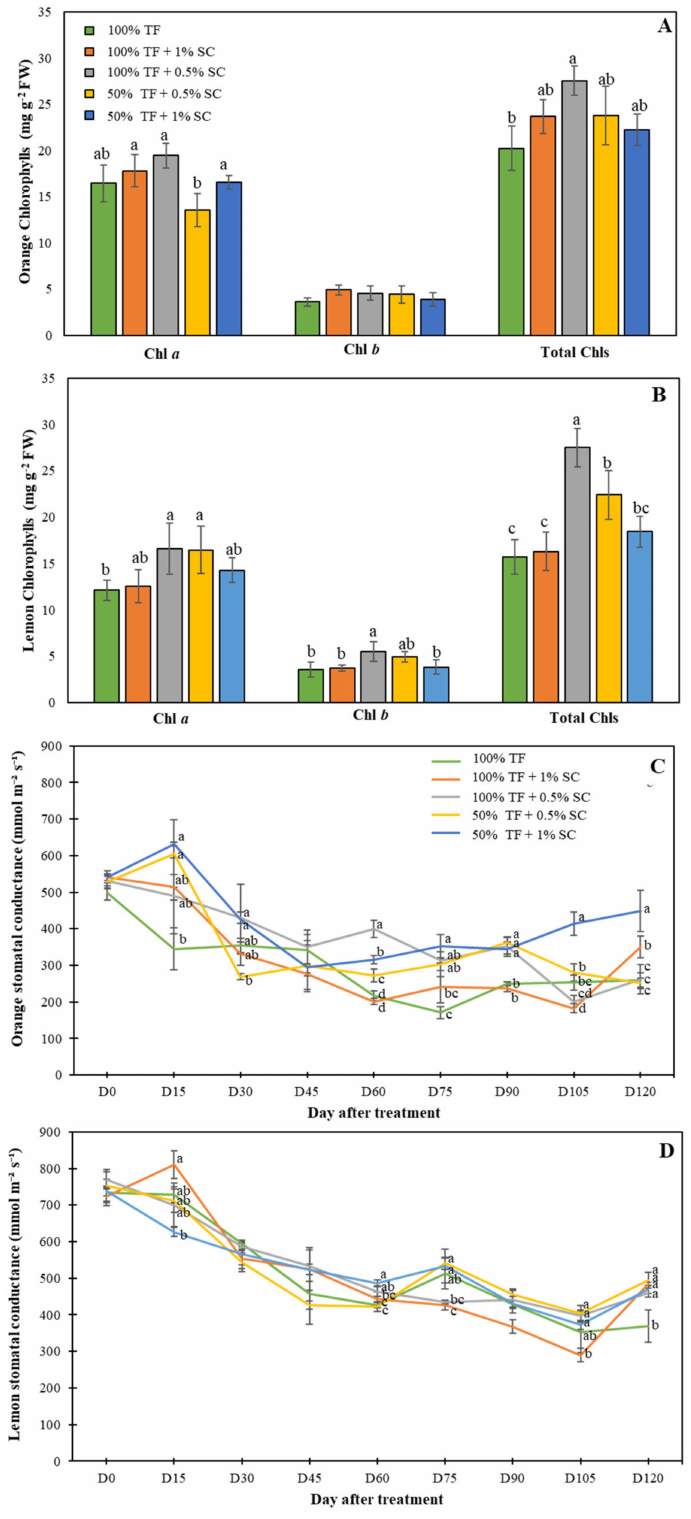
Figure 3. Chlorophyll contents ( A , B ) and stomatal conductance ( C , D ) of orange ( A , C ) and lemon ( B , D ) seedlings grew in the presence of 100% or 50% TF fertilizer and / or 0.5 or 1% SC for 120 days (D120). Means labeled by di ff erent letters are significantly di ff erent by Tukey’s post-hoc test ( p < 0.05). Error bars represent the standard deviation ( n =